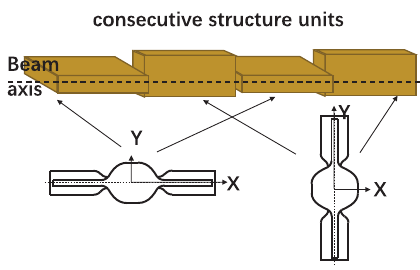
FIG. 22. Setup of rotating two consecutive structure units by 90